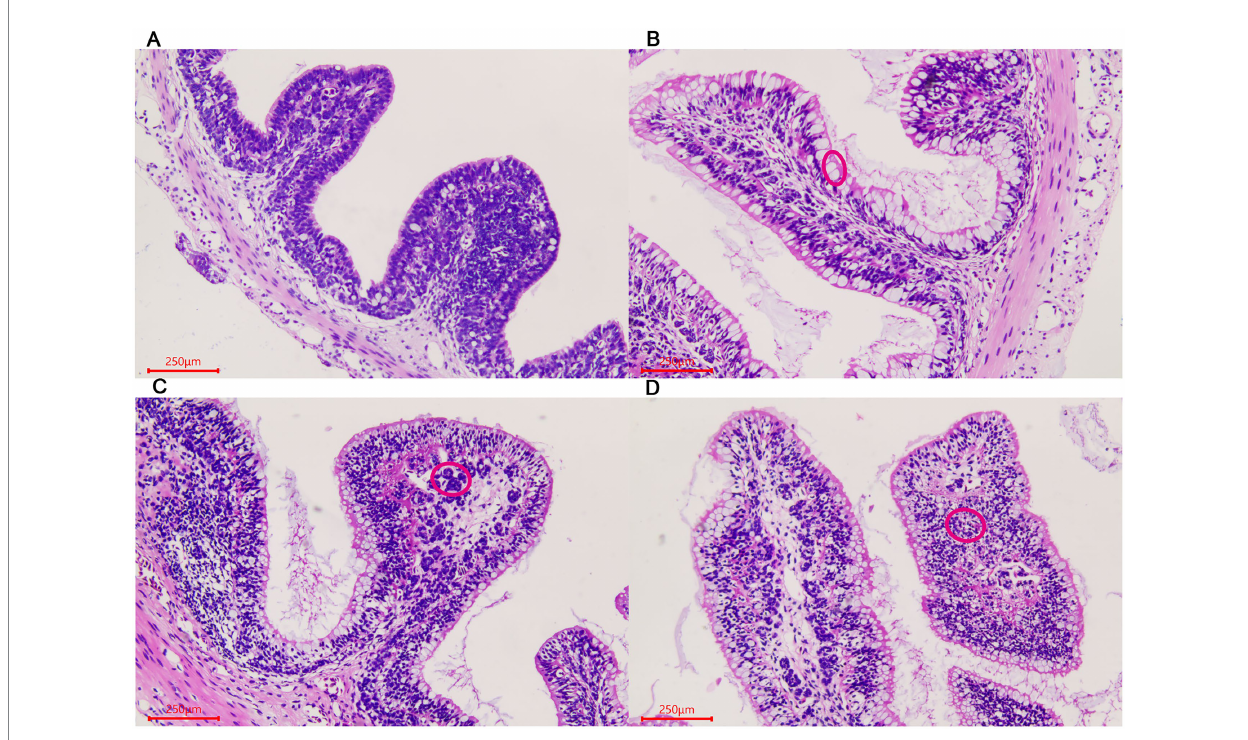
FIGURE 2 Morphological changes of the large intestine in A. davidianus. (A) The large intestine in ADY. (B) The large intestine in ADE. (C) The large intestine in ADS. (D) Glandular structures of the large intestine in ADS (as shown in red circle). The sections were observed using high power fields of 500-fold magnification with several measurements at different positions in each